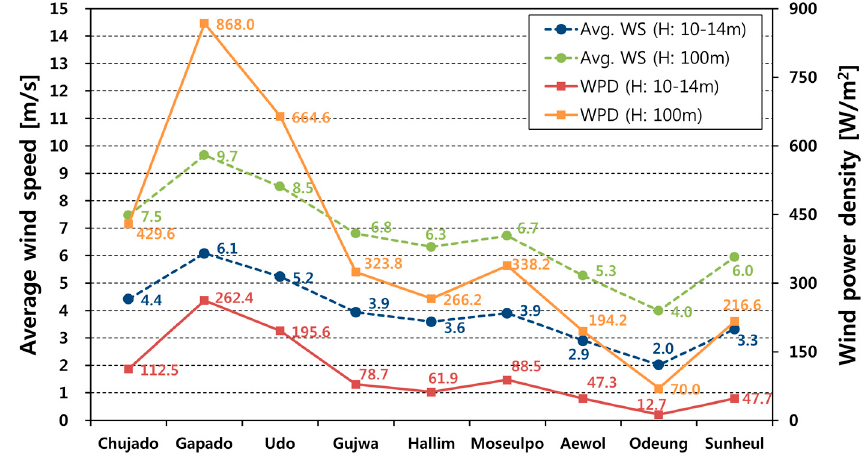
Figure 7. Five-year average wind speed and wind power density for all measurement sites.